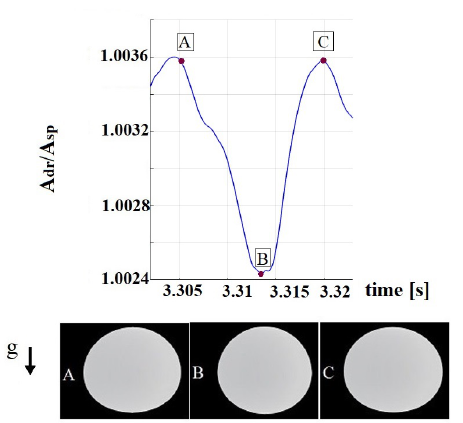
Figure 7. An example for the shape change of the simulated 3 mm water drop, falling in stagnant air.